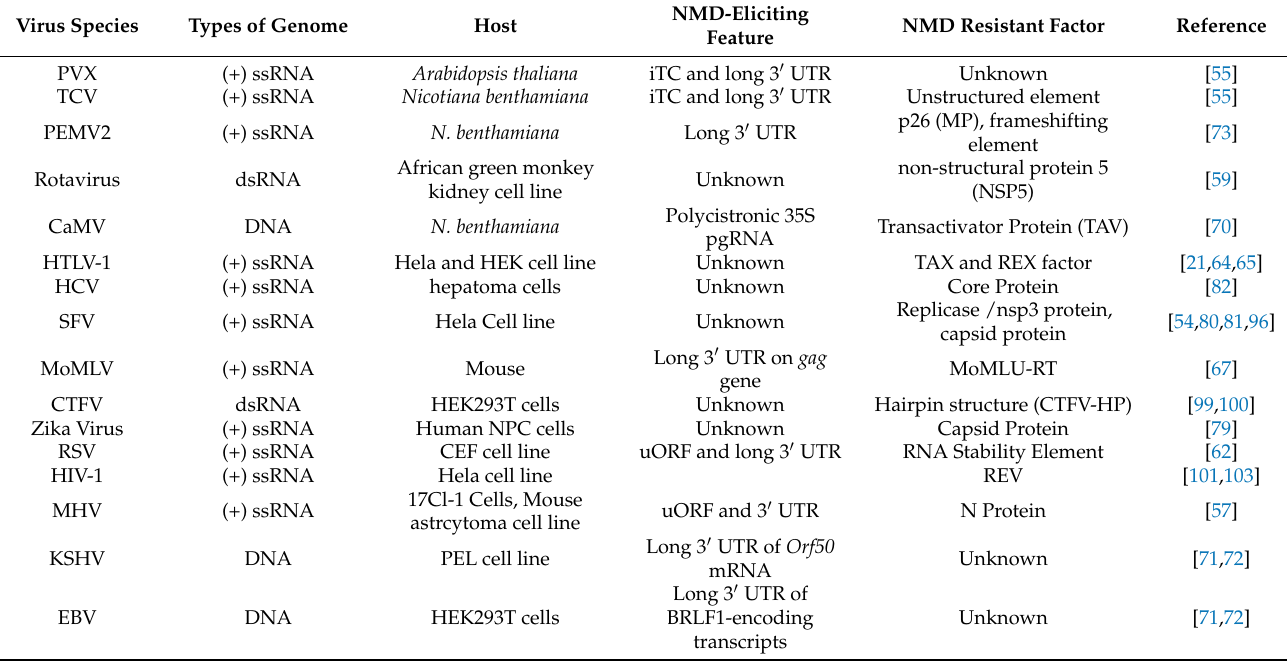
Table 1. Host NMD eliciting features and possible resistant factors of various